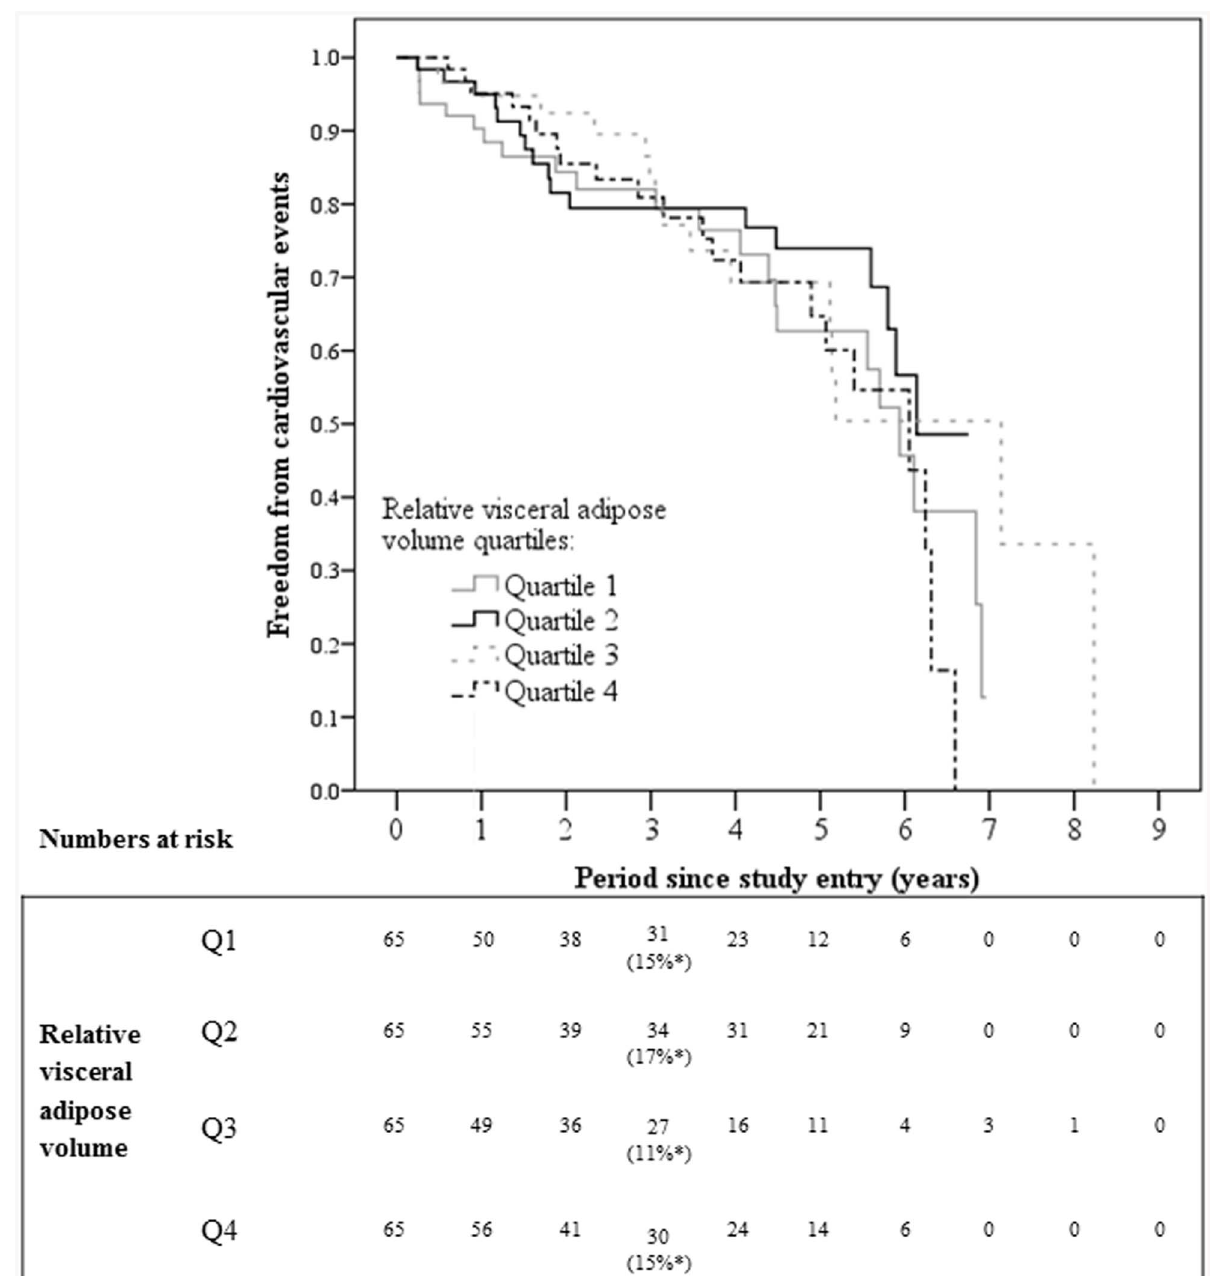
Figure 1. Kaplan Meier analysis illustrating freedom from cardiovascular events in relation to relative visceral adipose volume quartiles. There was no significant association between the incidence of non-fatal myocardial infarction, non-fatal stroke or death and visceral adiposity. *Cardiovascular event incidence at 3 years ( P =0.517).